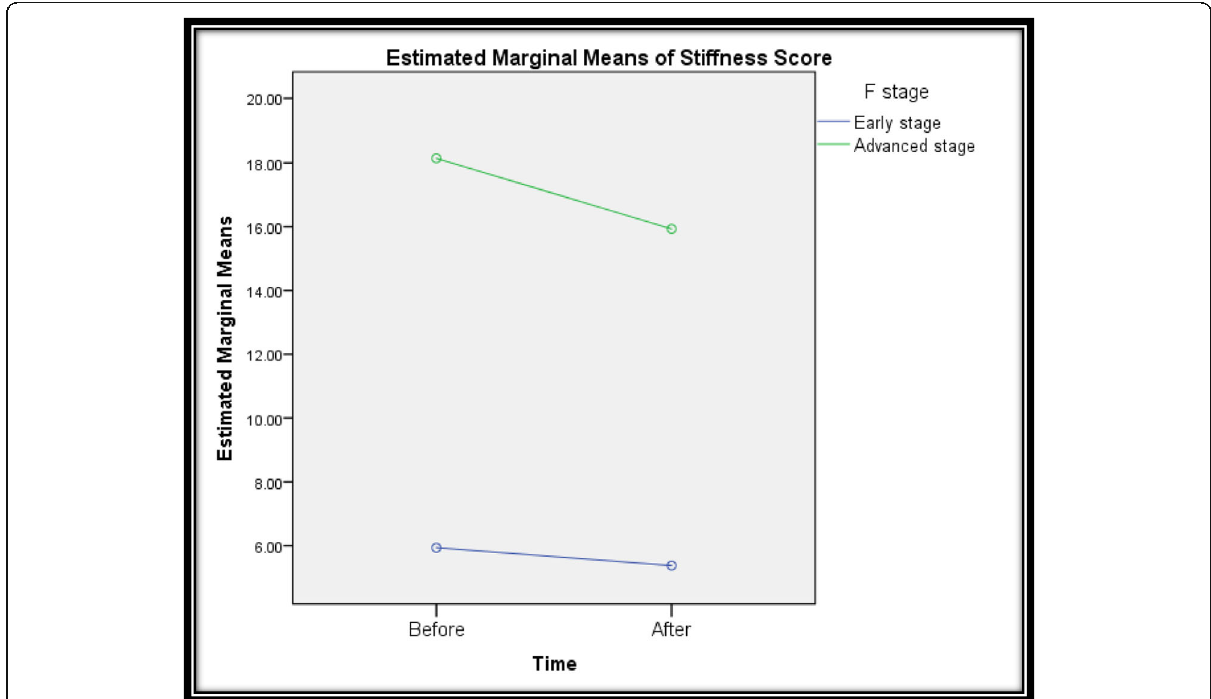
Fig. 2 Estimated marginal means of stiffness score in the early and advanced fibrosis